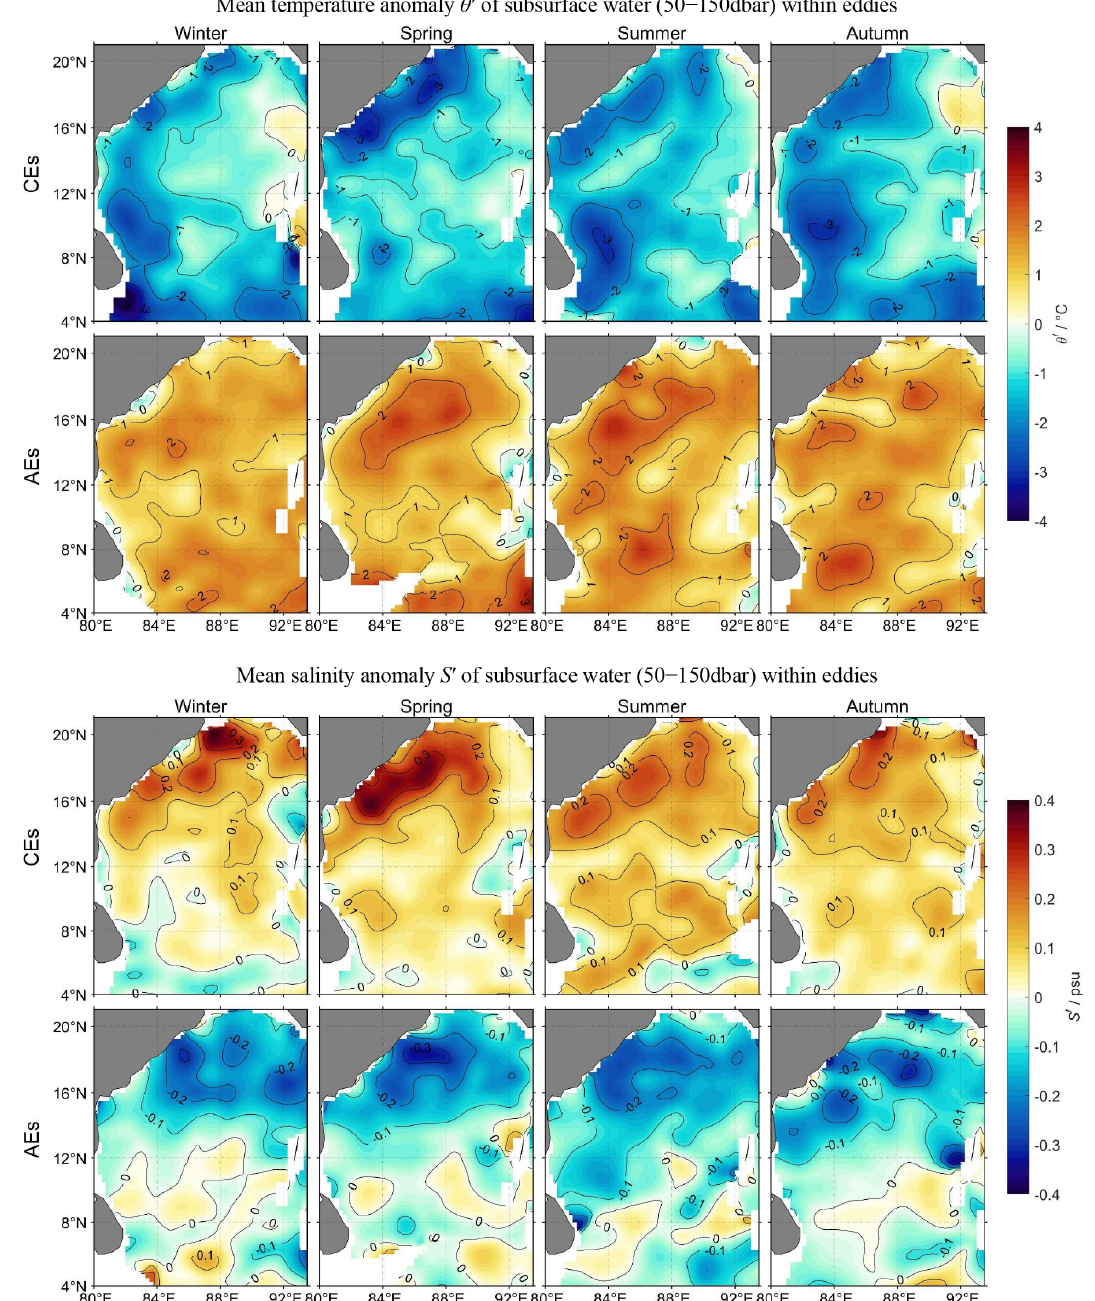
Figure 8. Spatial characteristics of the vertical temperature and salinity anomalies of cyclonic eddies (CEs) and anticyclonic eddies (AEs) in the Bay of Bengal in different seasons based on the weekly ARMOR3D temperature and salinity field